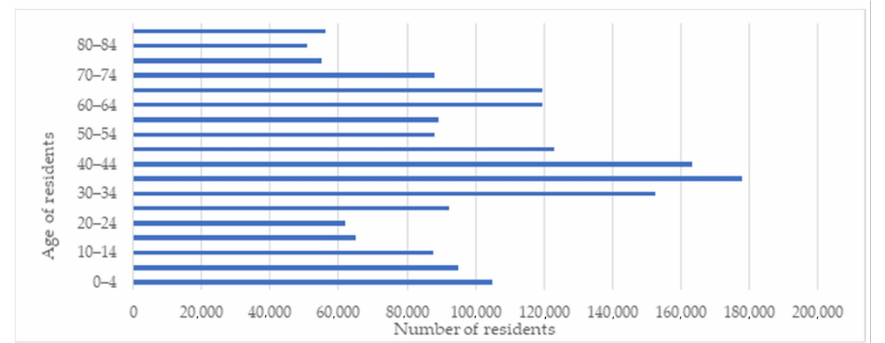
Figure 3. Demographic structure of Warsaw